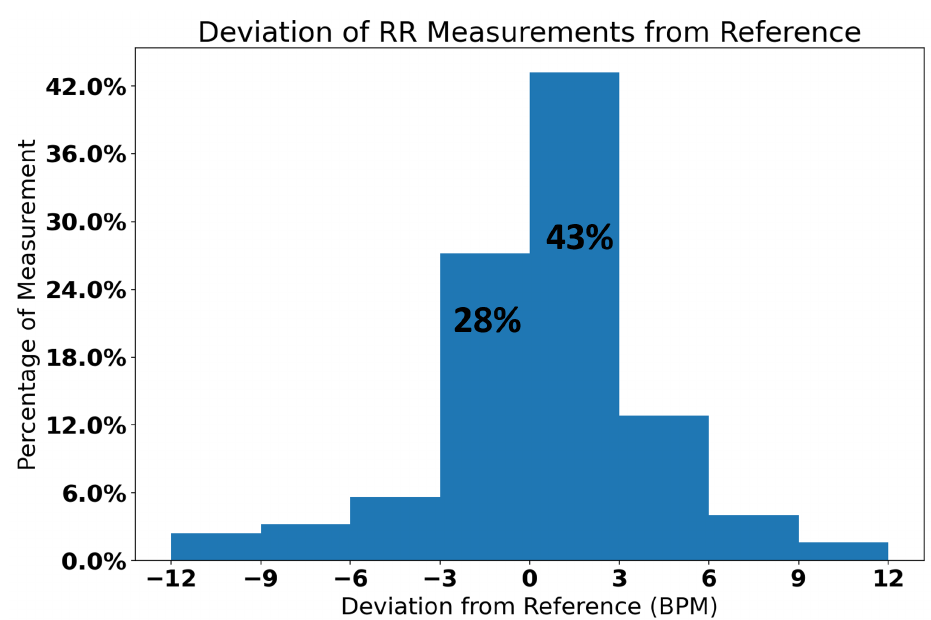
Figure 19. Typical RR motion measured by a ToF camera (blue), and the RR measured by the reference respiration belt (red).